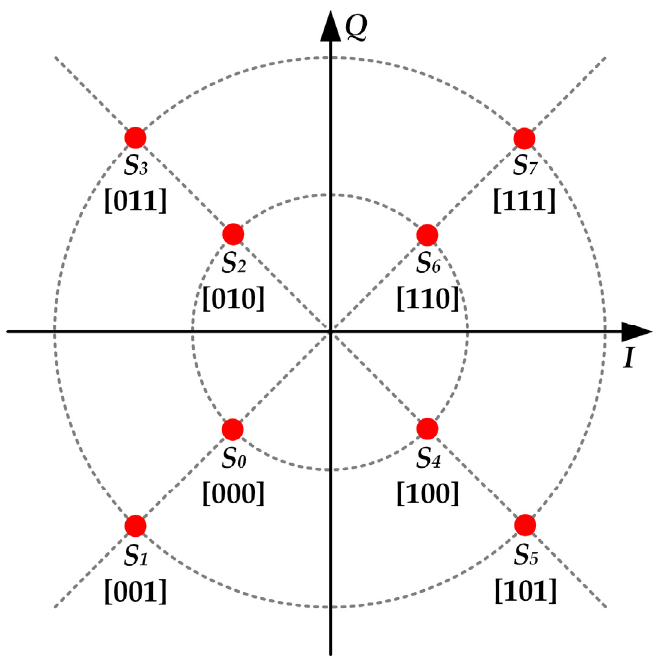
Figure 17. Constellation diagram of the reproduced dc-biased 8-QAM scheme.